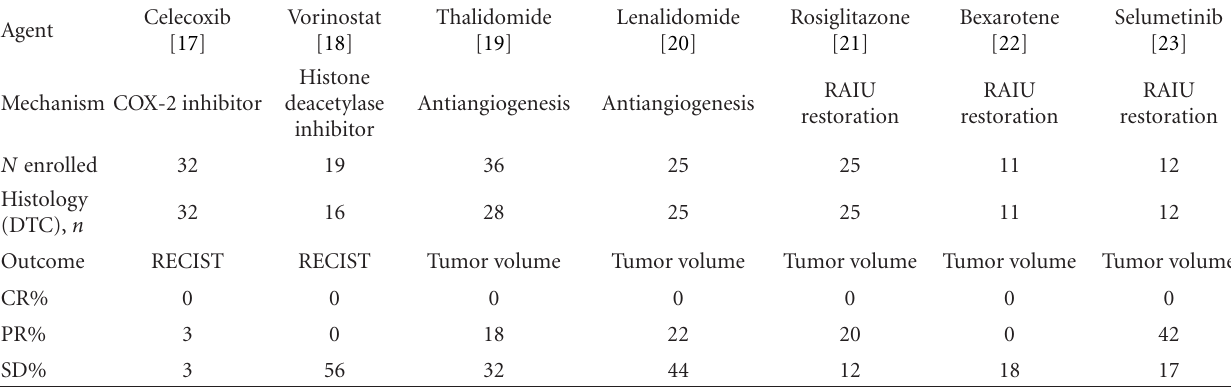
Table 2: Trials of other targeted therapies in patients with metastatic di ff erentiated thyroid